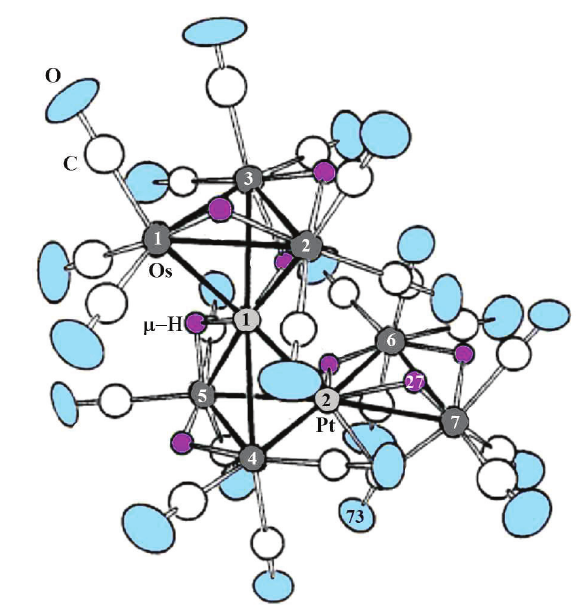
Os (µ-H) (CO) ] [15]. 2 7 8 23